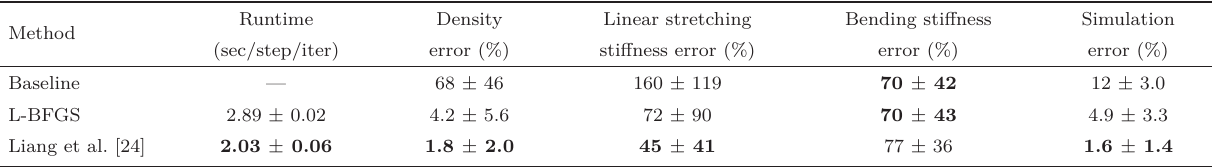
Table 1 Material parameter estimation results from Ref. [24]. Their proposed method runs faster than L-BFGS. Values of material parameters are Frobenius norms of the difference normalized by the Frobenius norm of the target. Values of the simulated result are the average pairwise vertex distances normalized by the size of the cloth. The gradient-based method yields much smaller errors than the